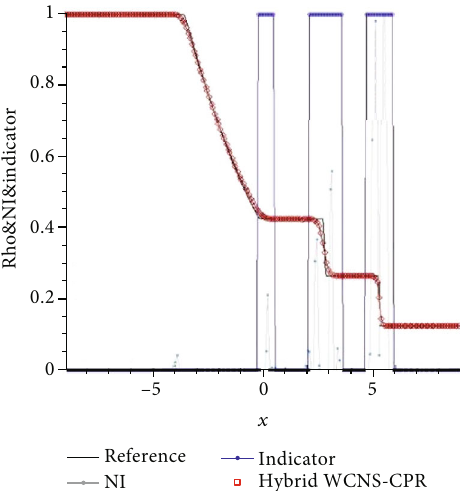
Figure 9: Density numerical solution and shock detection result of the hybrid WCNS-CPR scheme for the 1D Shu-Osher problem.